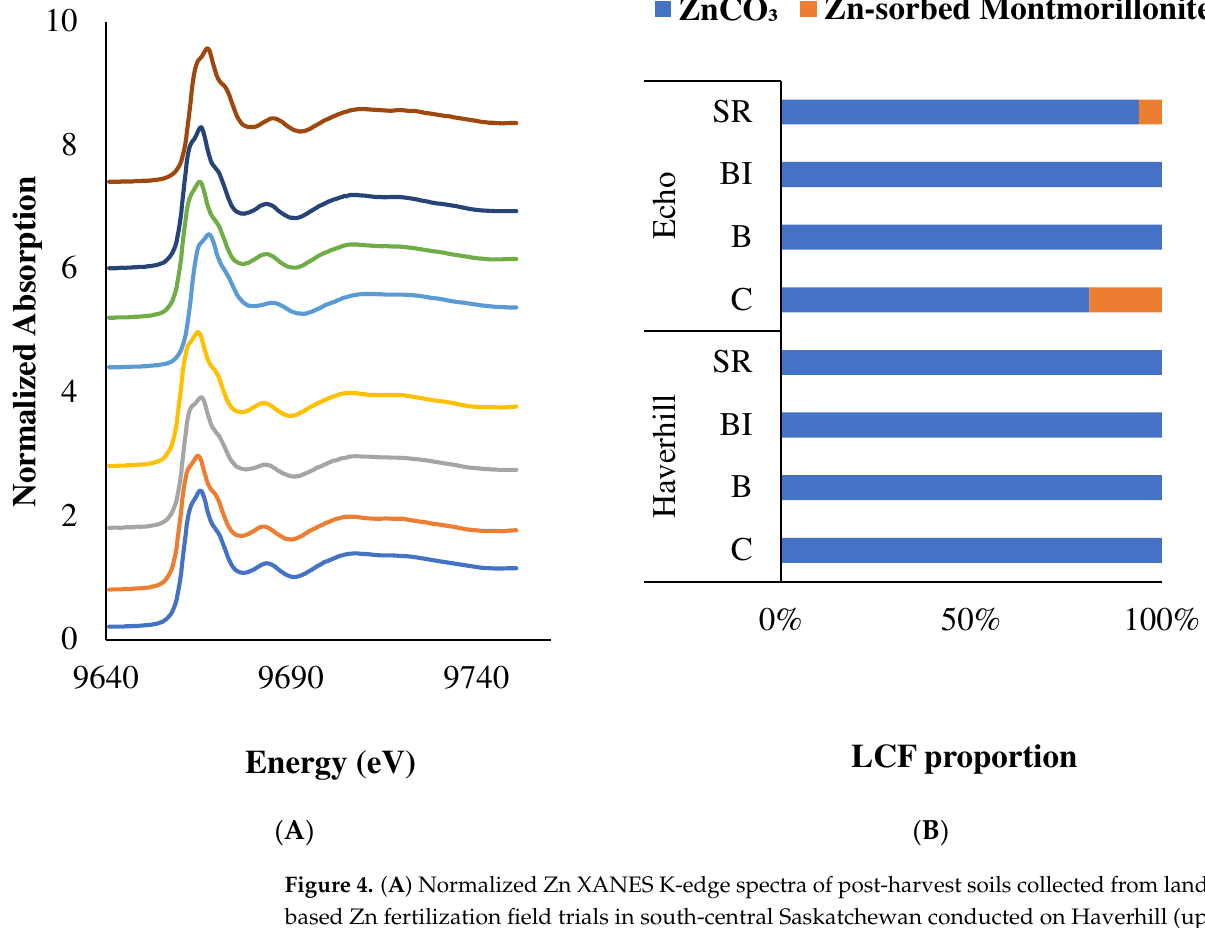
broadcast; Cu BI: broadcast and incorporation Cu; and SR: seed row banding of sulfate form of Cu fertilizer at the rate of 2 kg ha −1 .